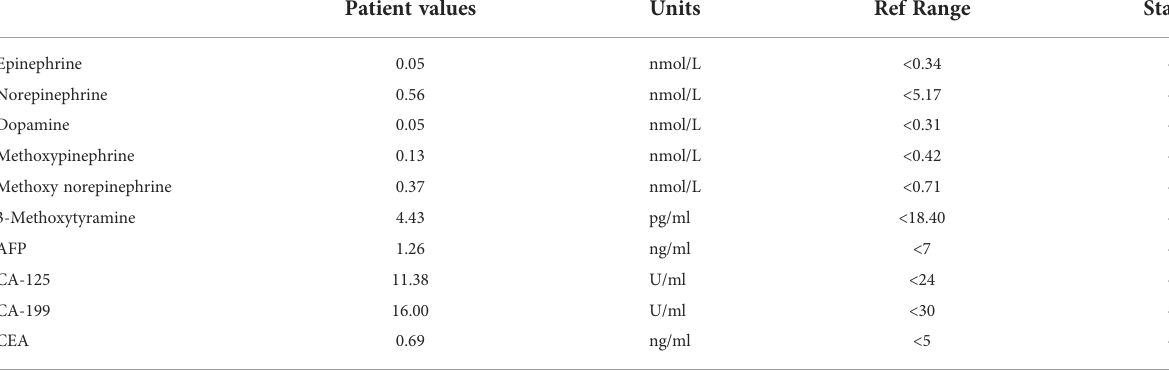
Table 1 Laboratory tests for catecholamine metabolism and tumor